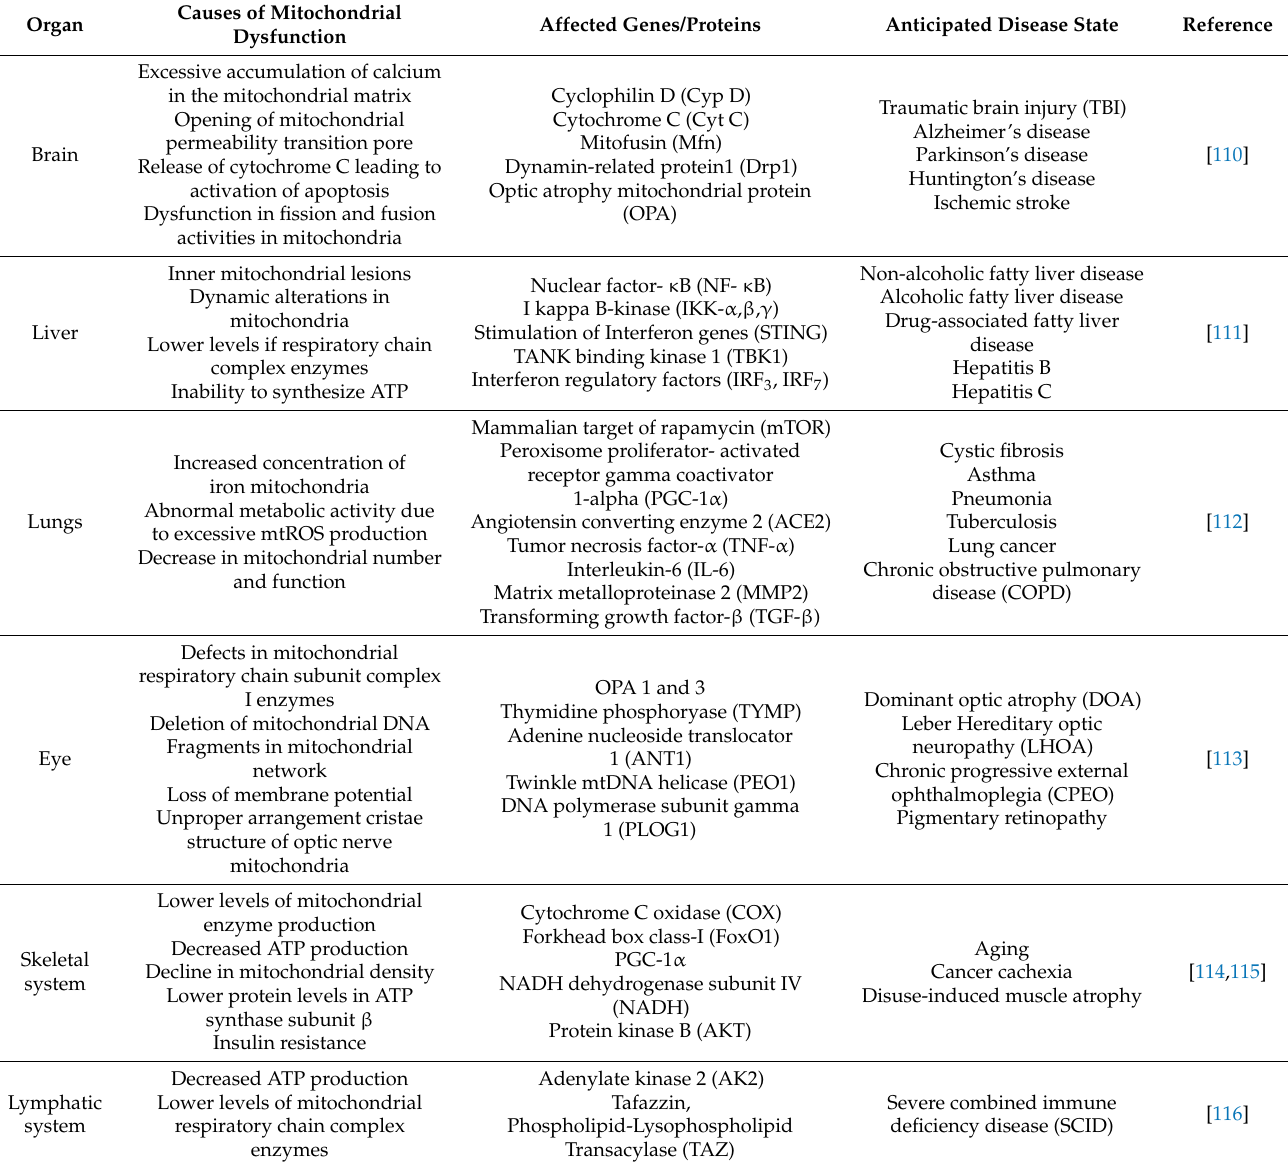
Table 1. The molecular causes of mitochondrial dysfunction in various organs in the body.